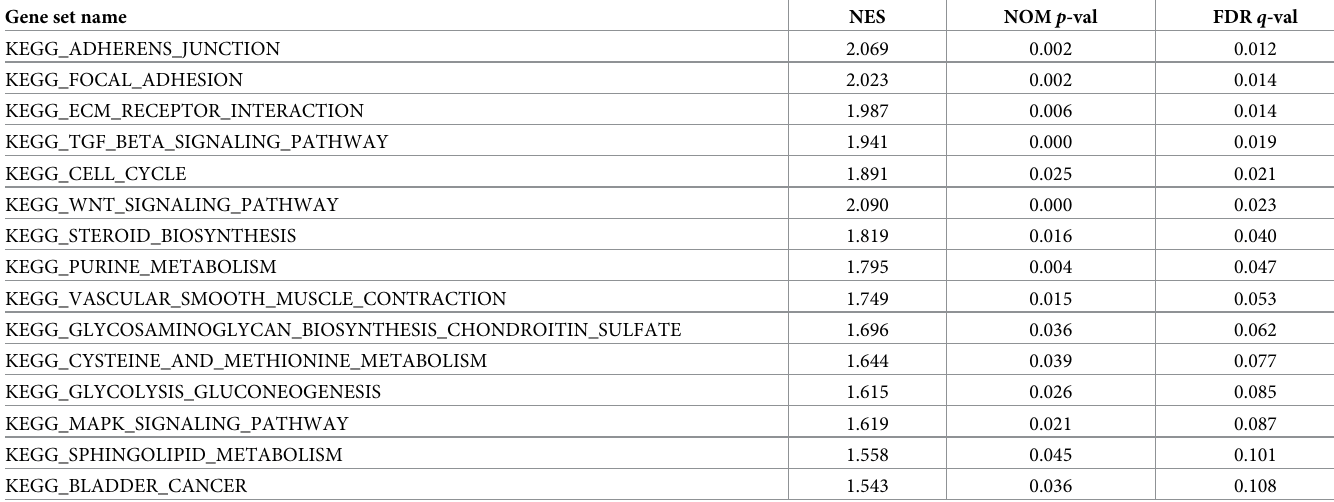
Table 7. Gene sets enriched in the high-risk phenotype via KEGG. Gene set